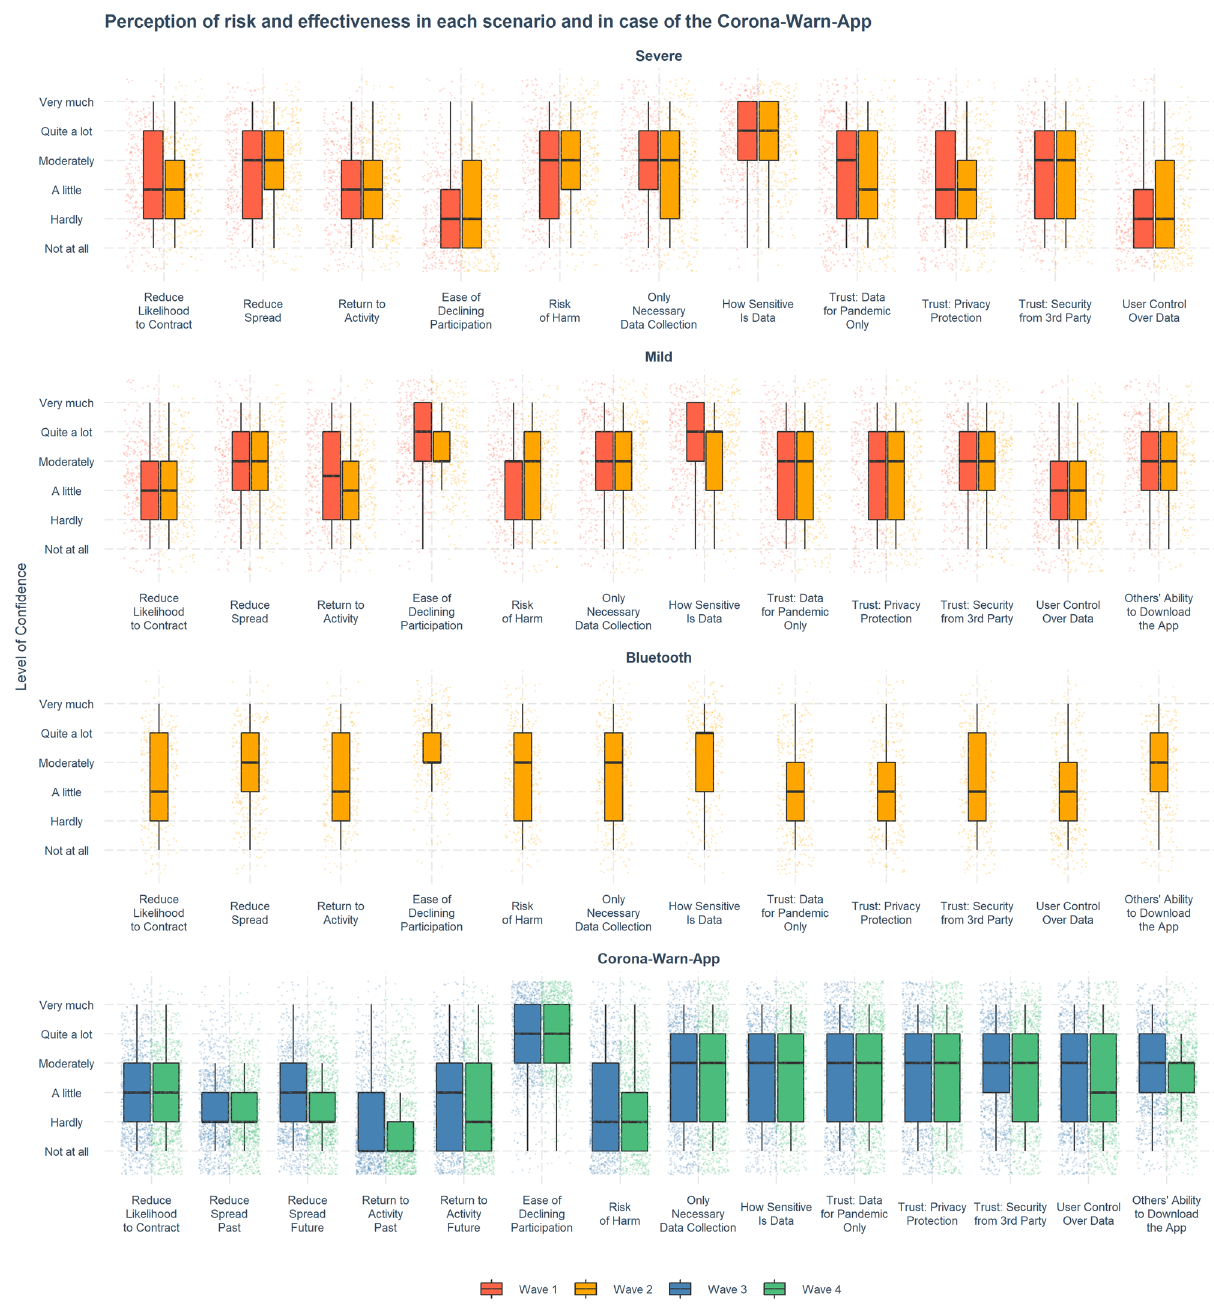
Figure 6. Perception of effectiveness and risks of the tracking policy in each scenario. Boxes show the interquartile range (IQR; responses between the 25th and 75th percentiles); the black horizontal line inside the boxes indicates the median value. Lower and upper whiskers extend from the hinge to the smallest and largest values within 1.5 × IQR . Individual responses are jittered horizontally and vertically. For items, see Supplementary Table B6; for descriptions of scenarios, see Supplementary Table